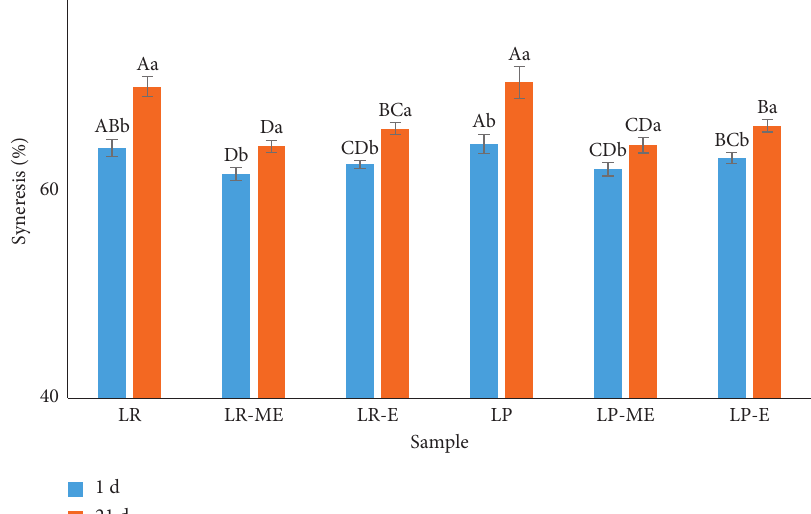
Figure 7: Syneresis of probiotic yogurt. LR ( L. rhamnosus ), LR-ME (encapsulated L. rhamnosus in multilayer emulsion), LR-E (en- capsulated L. rhamnosus in emulsion), LP ( L. plantarum ), LP-ME (encapsulated L. plantarum in multilayer emulsion), and LP-E (en- capsulated L. plantarum in emulsion). Capital letters indicate significant differences between samples at the same storage time and different time; lowercase letters indicate significant differences between the same samples at different storage